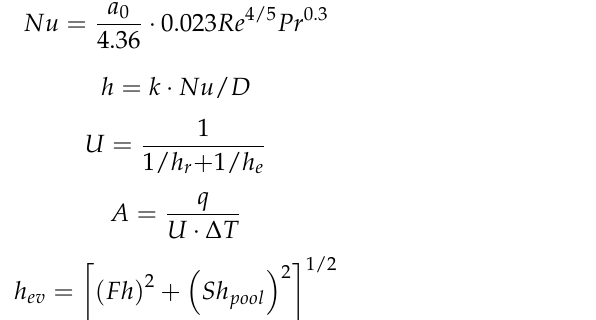
where a 0 is the scaling factor, 8.24 for the exhaust gases, and 5.39 for the working fluid, respectively. Re is the Reynolds number based on hydraulic diameter, Pr is the Prandtl number, k is the thermal conductivity of the fluid, D is the hydraulic diameter of the flow channel calculated by the parameters in Table 1, F and S are the forced convective heat transfer enhancement factor and suppression factor, respectively, h pool is the pooling boiling transfer coefficient [42]. Process 4–5: Saturated vapor from the evaporator at state 4, having an elevated temperature and pressure, expands through the expander to produce work and is then discharged to the condenser at state 5 with relatively low pressure. Neglecting heat transfer with the surroundings, the mass and energy rate balances for a control volume around the expander reduce at the steady state to give: